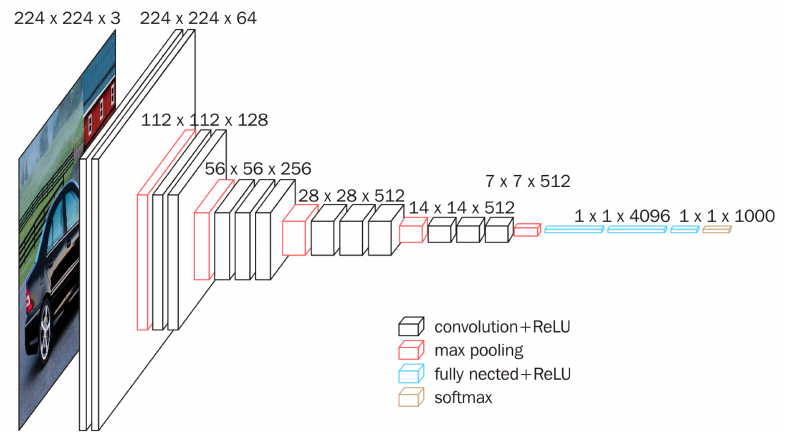
Figure 5. The network structure of VGGNet.